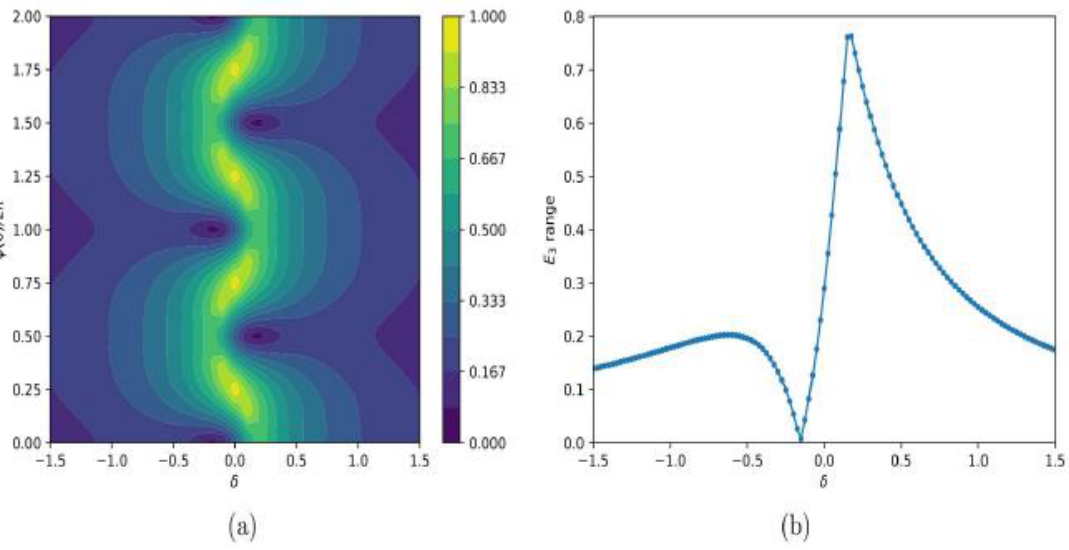
Figure 4. Color online. The fluctuation range of the energy E 3 for the triad ( 4,12 )( 5,14 )( 9,13 ) which is an isolated resonant train in the truncation N = 21, [11]: ( a ) as a function of (artificial) detuning δ and initial phase φ (at time t = 0; two 2 π periods in φ ( 0 ) are shown); ( b ) as a function of δ at φ ( 0 ) = 0. The initial energies are E 1 ( 0 ) = 0.4, E 2 ( 0 ) = 0.4, E 3 ( 0 ) = 0.2, which is case ( b ) of [16].